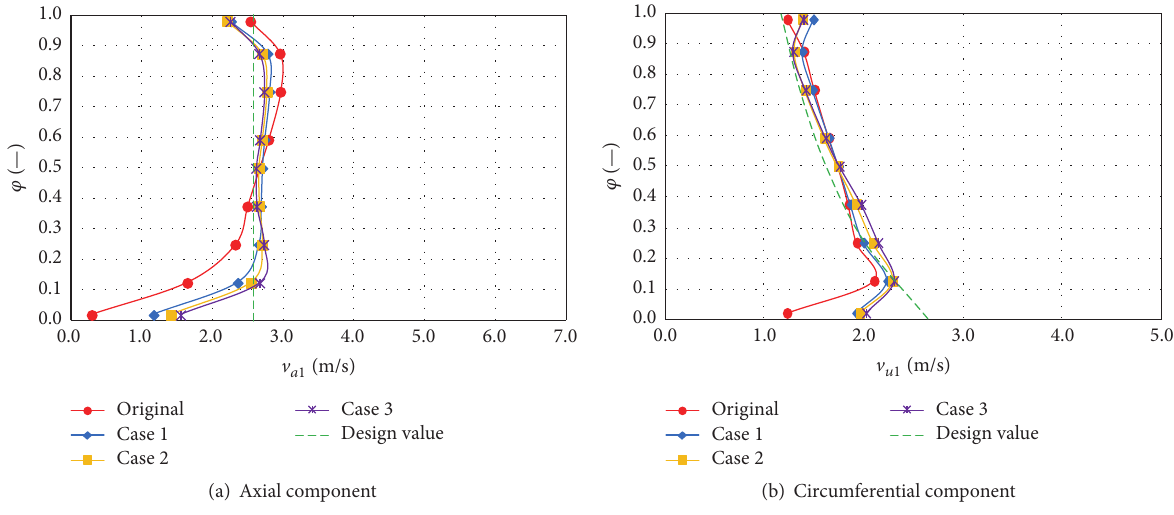
Figure 9: Absolute velocity at runner inlet ( 𝑛 = 2460 min −1 ,